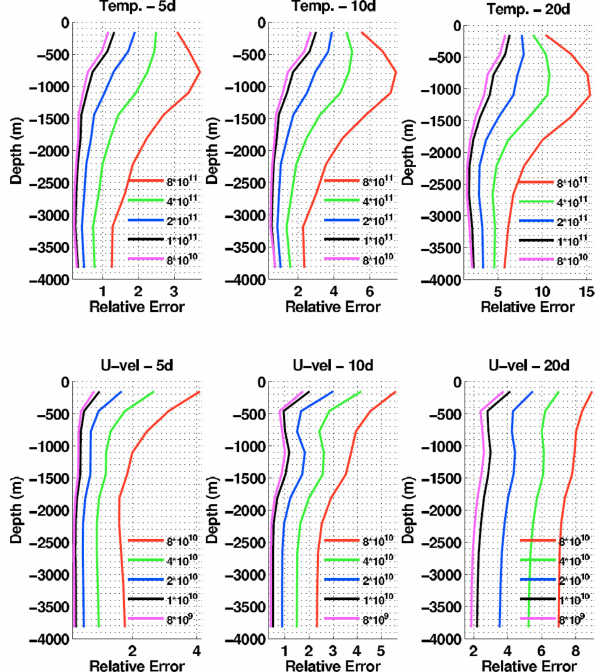
Figure 2. Vertical profiles of relative errors in the initial condi- tion after one forward–backward model integration without nudg- ing. Each colour refers to an experiment performed using the dif- fusion coefficient indicated in the figure legend. Red curves were obtained using the same diffusion coefficients as in the reference experiment. Top panel: temperature errors; bottom panel: zonal ve- locity errors. The length of the time window is indicated in the title of each figure.